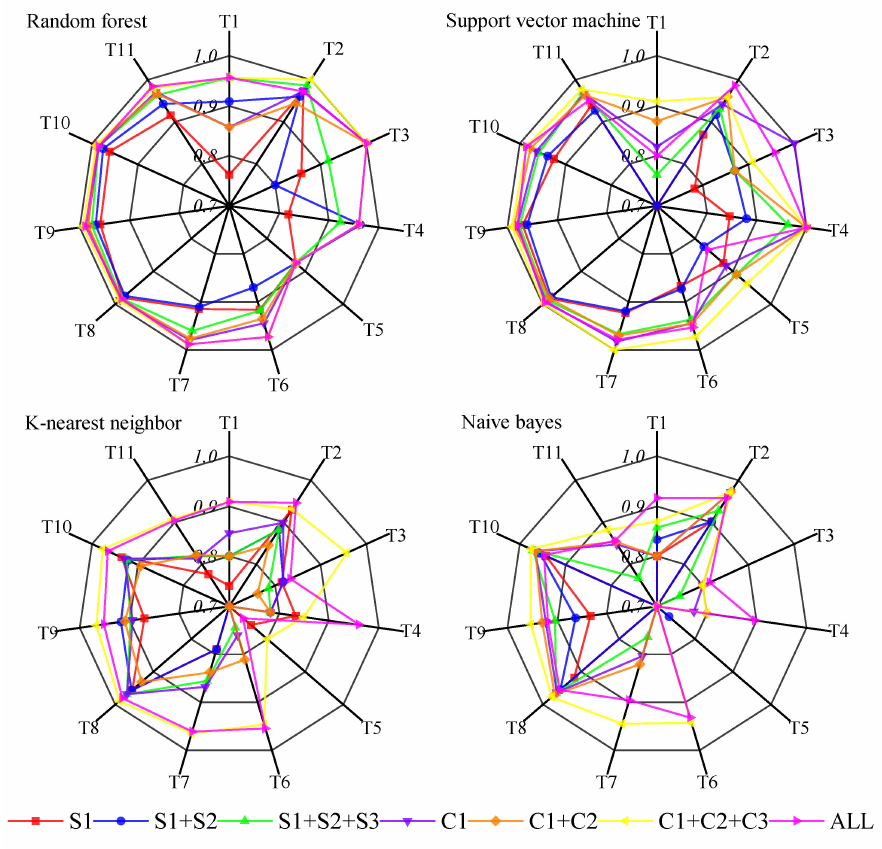
Figure 6. F1 score of object-based classifiers under different feature